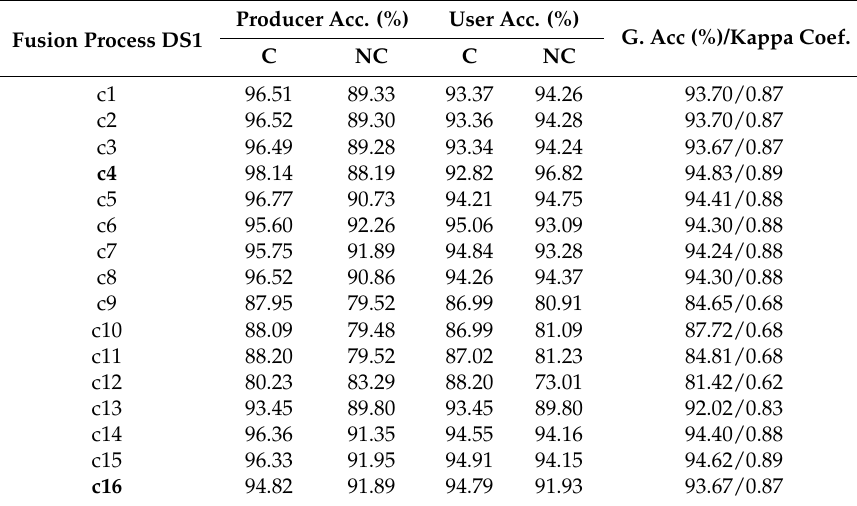
Table 10. DS1. Accuracy analysis of the Probabilistic Information Fusion